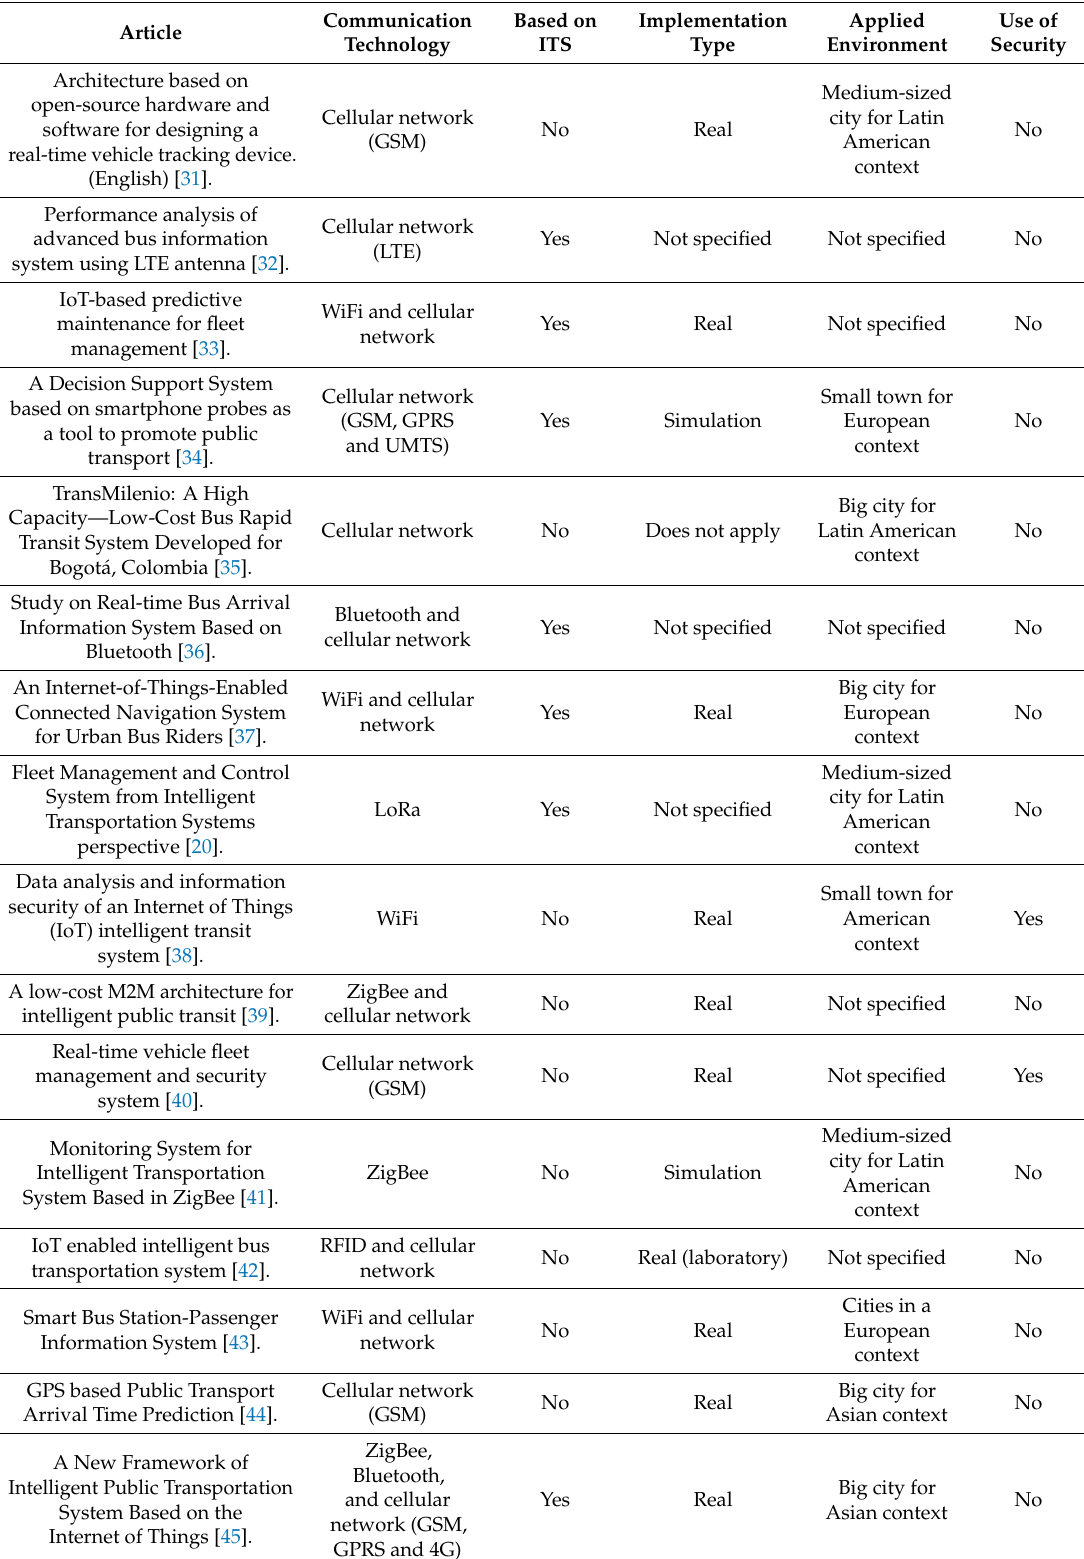
Table 1. Documents of mobility services of Fleet Management and Control Systems (FMCS).